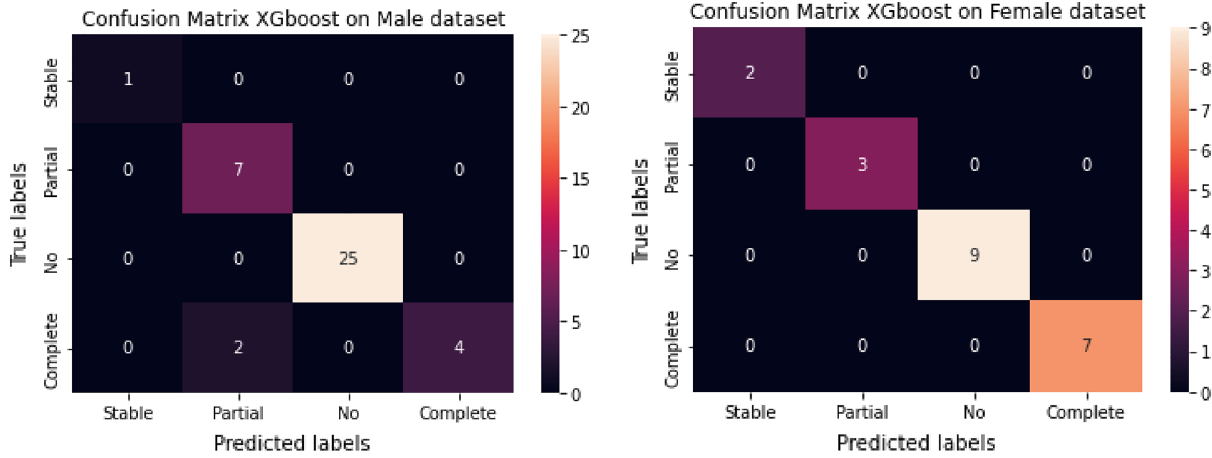
Figure 9. Confusion matrices for the XGBoost model on gender-stratified